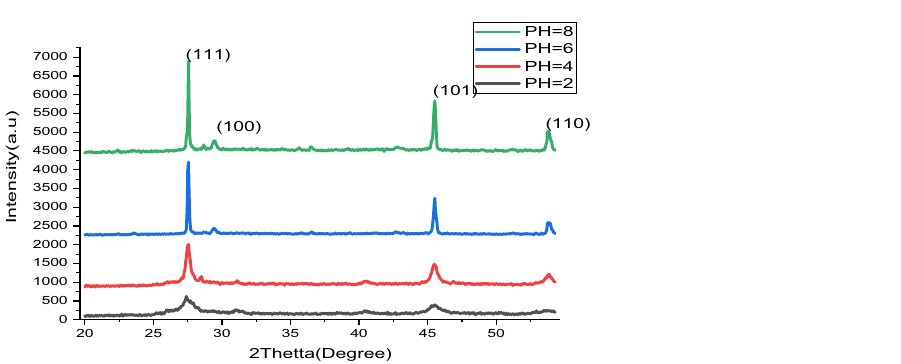
Figure 4. X-Ray Diffraction pattern of Lead Sulfide films from Avocado ( Glycosmis cochinchinensis ) Leaf extracts at different pH values varied as 2, 4, 6 and